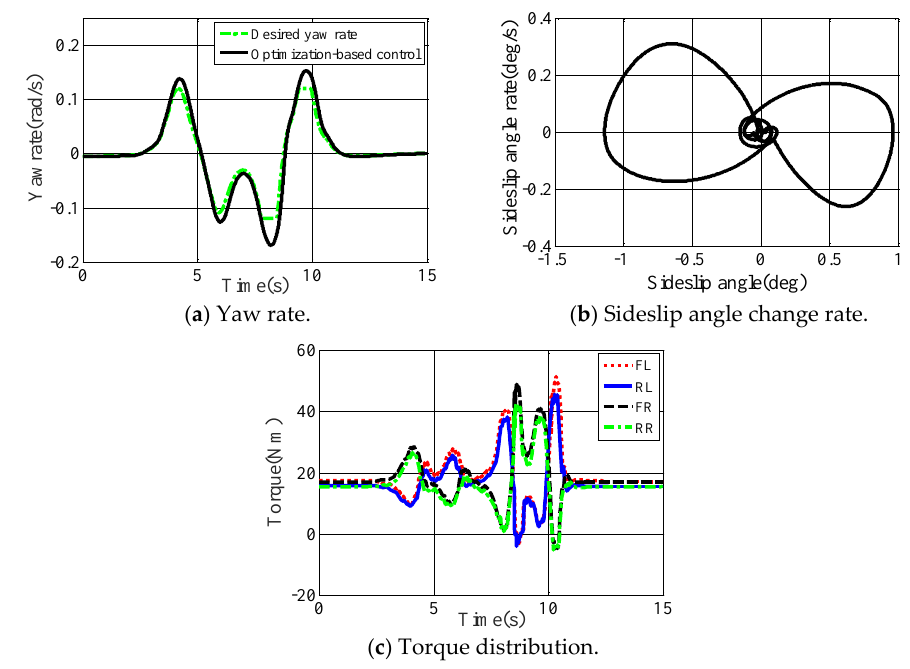
Figure 13. Experimental results for double lane change with low friction.